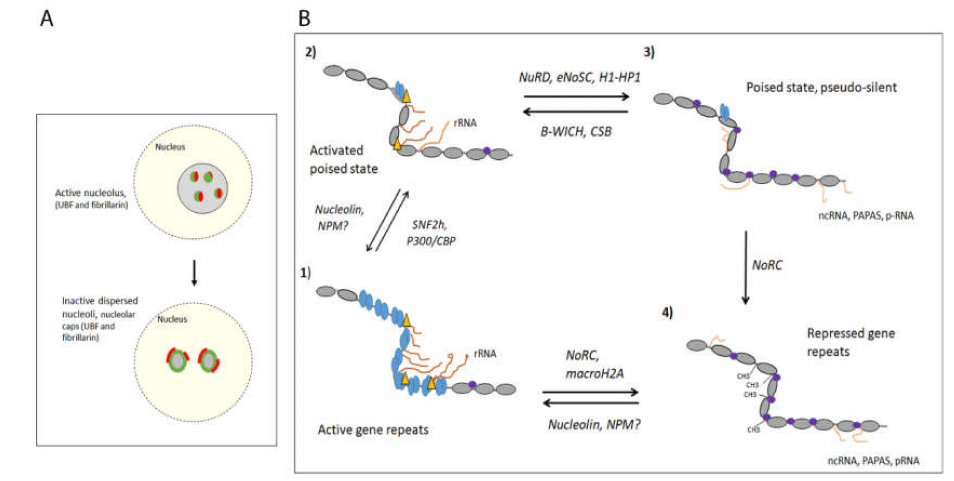
Figure 1. ( A ) The nucleolar integrity in active and dispersed nucleoli. Nucleolus with several FCs reflecting active transcription, with UBF (green) and fibrillarin (red) assemblies surrounded by GC. (top panel), and nucleus exposed to stress such as DNA damage or starvation, reducing transcription, leading dispersed nuclei with a different organisation, here shown with nucleolar caps, UBF (green) and fibrillarin (red) at the periphery and GC-component in the interior (bottom panel). ( B ) Different chromatin states of the mammalian rDNA and the chromatin remodelling complex identified. (1) The active chromatin state is organised with UBF (bleu ovals), which imposes an open, decondensed chromatin state that is transcriptionally active if induced by transcription factors (RNA pol I is marked with a yellow triangle), with nucleosomal chromatin (grey ovals) in the IGS; (2) the activated poised state, organised with nucleosomes (grey ovals) and is transcriptionally active (RNA pol I is depicted with a yellow triangle, (3) the permissive poised state or the pseudo- silent state, organised with nucleosomes carrying histone PMTs and heterochromatin factors (marked with purple circles), and transcriptionally inactive, (4) the constitutively repressed chromatin state, organised in heterochromatin with DNA- methylations and is transcriptionally silent. The chromatin remodelling complexes and histone chaperones involved in the switches between states are depicted around the arrows. RNAs are shown, the sense 47S rRNA transcript in (1) and (2) and ncRNA species from the IGS in (3) and